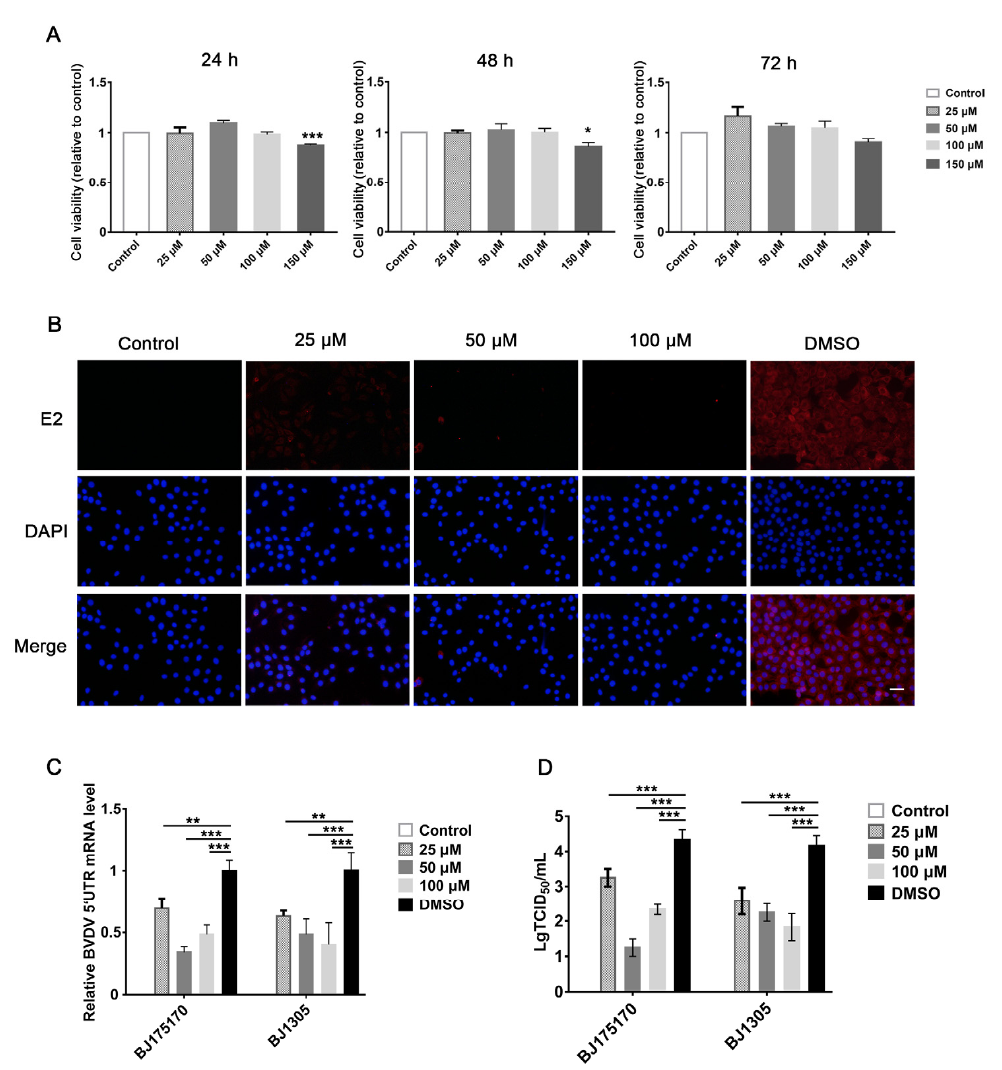
Figure 1. Gypenoside inhibits BVDV replication in MDBK cells. ( A ) Cell viability in MDBK cells after treatment with 25–150 µ M gypenoside for 24–72 h. ( B ) IFA of BVDV-infected cells treated with escalating doses of gypenoside (25–100 µ M) or DMSO. BVDV E2 protein (red) and DAPI (blue). Scale bars represent 100 µ m. ( C ) The expression of BVDV 5’UTR mRNA in BVDV-infected MDBK cells treated with the indicated concentrations of gypenoside at 24 hpi. ( D ) The TCID50 result for BVDV titers in BVDV-infected MDBK cells treated with the indicated concentrations of gypenoside at 24 hpi. The control is the untreated and uninfected group. Data from three independent experiments and error bars are presented as the mean ± SEM. * p < 0.05, ** p < 0.01, *** p <